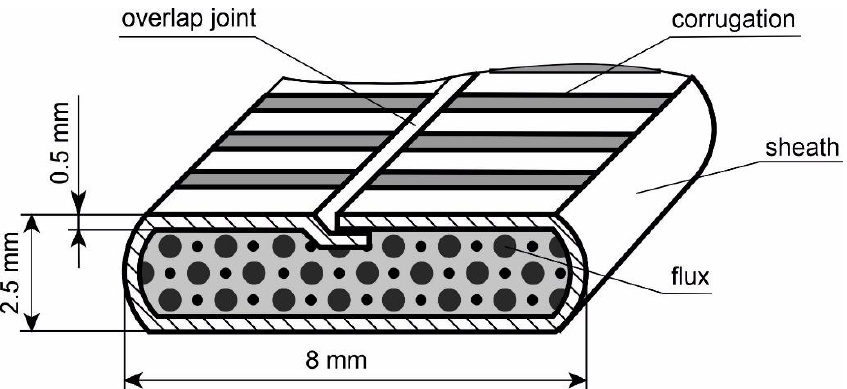
Table 2. Mechanical properties of the 08kp steel.